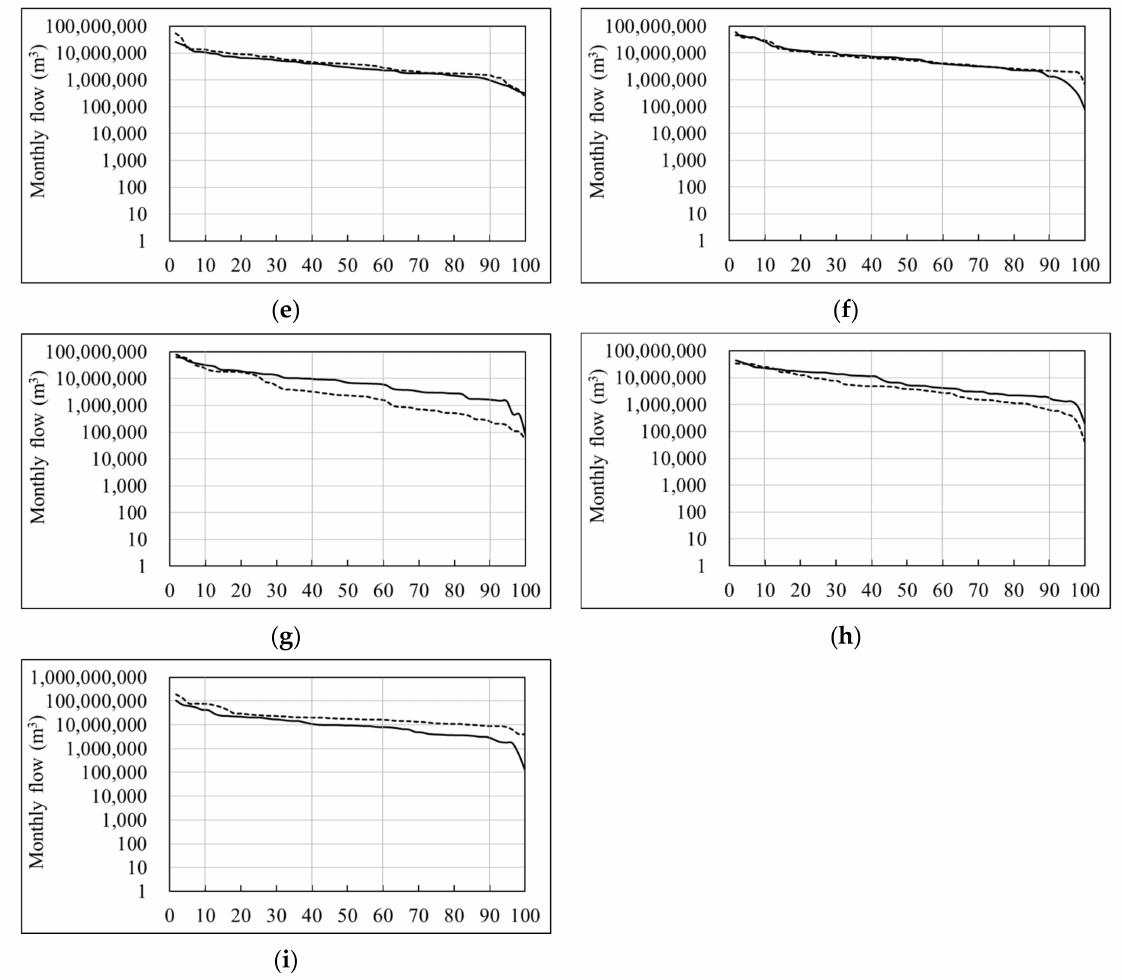
Figure 6. Flow duration curves of separated monthly baseflow and estimated monthly baseflow in validation: ( a ) Wsd-03; ( b ) Wsd-05; ( c ) Wsd-07; ( d ) Wsd-09; ( e ) Wsd-11; ( f ) Wsd-13; ( g ) Wsd-15; ( h ) Wsd-17; ( i )